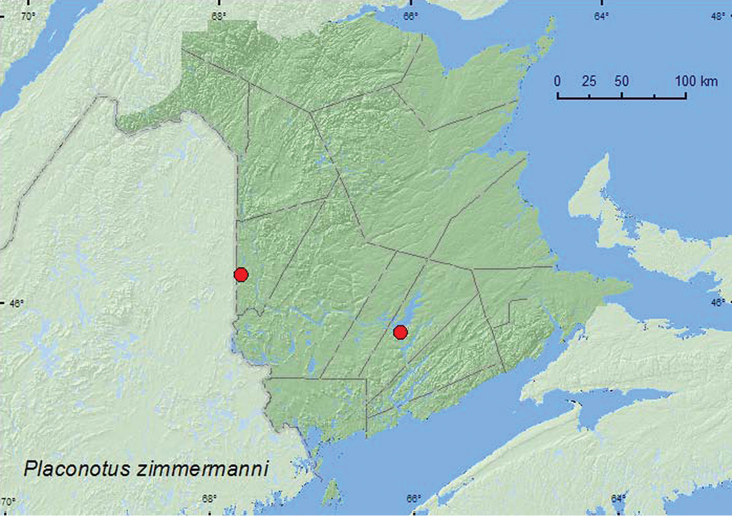
Collection localities in New Brunswick, Canada of Placonotus zimmermanni.